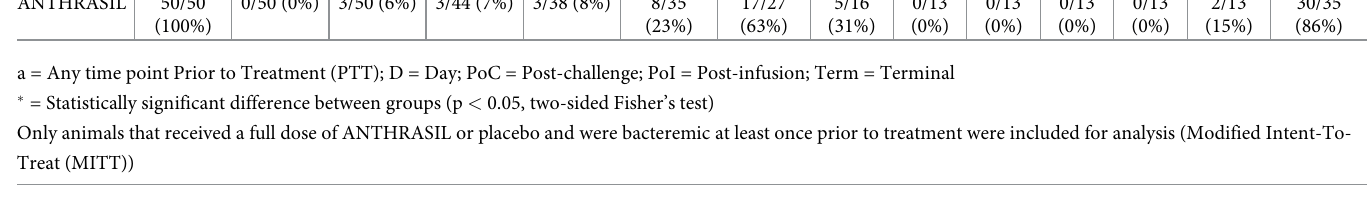
of bacteremia was significantly better by Day 3 post-infusion in ANTHRASIL-treated animals than IGIV controls (26% vs 2%, p = 0.0074). Hematology. The hematological examination was performed prior to infusion, on Days 2 and 10 PoI, and on terminal specimens. Mean levels of red blood cells (RBCs), hemoglobin (HGB) and hematocrit (HCT) dropped below normal ranges (~40% reduction over the base- line value) after infusion of ANTHRASIL or IGIV, suggesting the animals were becoming ane- mic; however, this never became severe enough to warrant euthanasia or other intervention. While all terminal specimens were below normal ranges, it was not determined if the levels in surviving animals returned to normal as no specimens were collected after Day 10 PoI. The mean levels of RBCs, HGB, and HCT were slightly below normal ranges in ANTHRASIL-